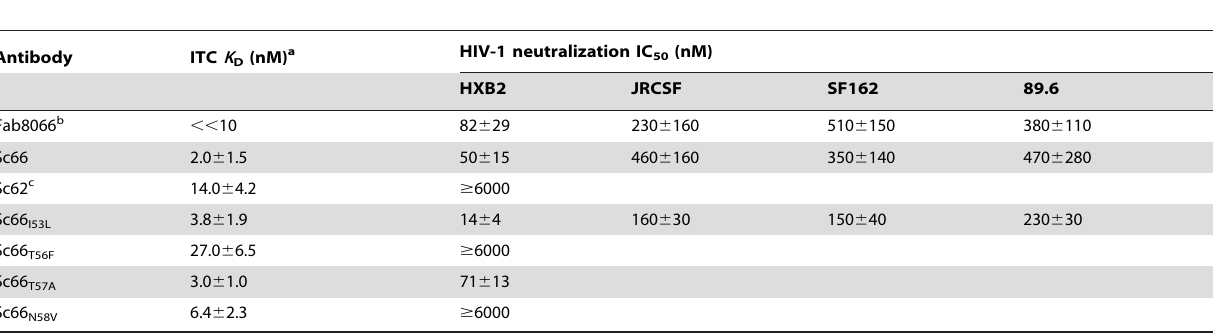
Table 1. Comparison of equilibrium dissociation constants for the binding of ScFvs to 5-helix determined by ITC and HIV-1 neutralization potency in an Env-pseudotyped neutralization